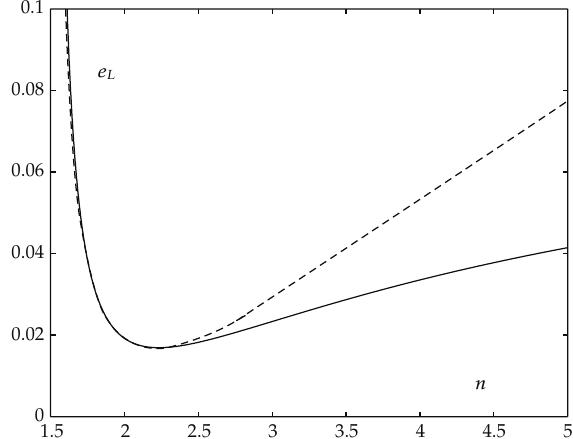
Figure 1: Plot of e L (cid:3) n (cid:4) for n ∈ (cid:3) 1 . 5 , 5 (cid:6) . The solid line denotes the HBIM formulation and the dashed line denotes the RIM